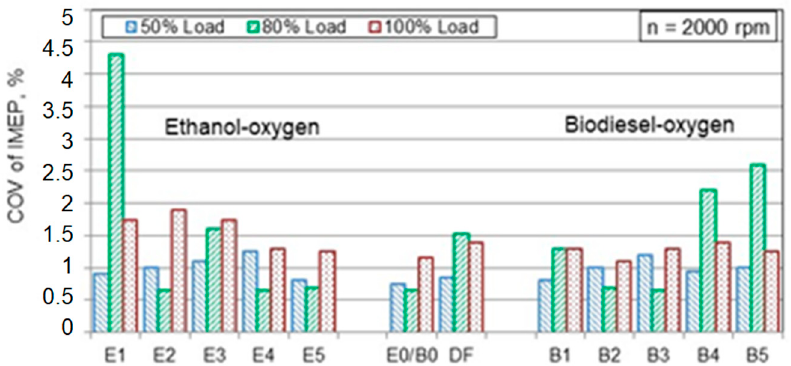
Figure 7. Coefficient of the cyclic variation (COV) of IMEP as a function of ethanol–oxygenated or biodiesel-oxygen mass content (wt%) in fuel blends for medium (50%), intermediate (80%), and full (100%) loads corresponding to respective IMEPs of 0.75, 1.20, and 1.50 MPa, developed at maximum torque speed of 2000